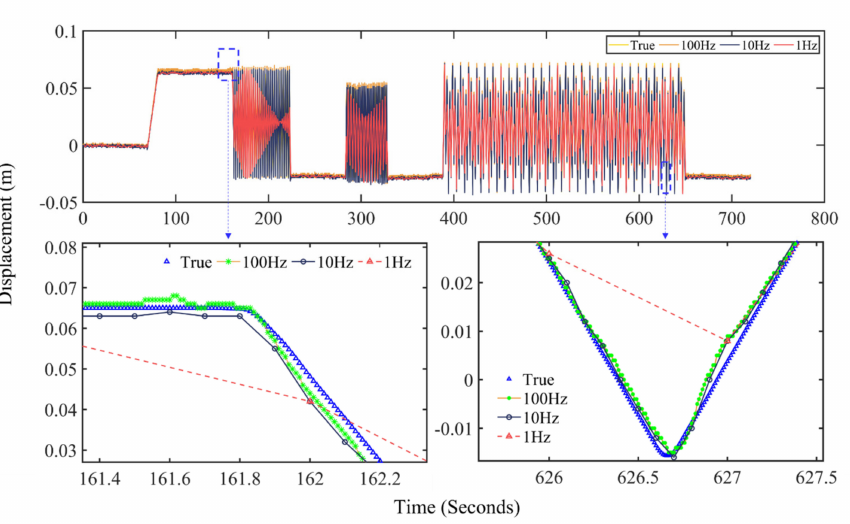
Figure 13. 100-Hz, 10-Hz, and 1-Hz displacement time series corresponding to quasi-static and sinusoidal motions derived from multi-GNSS observations and RTK technique (starting from 08:32:00